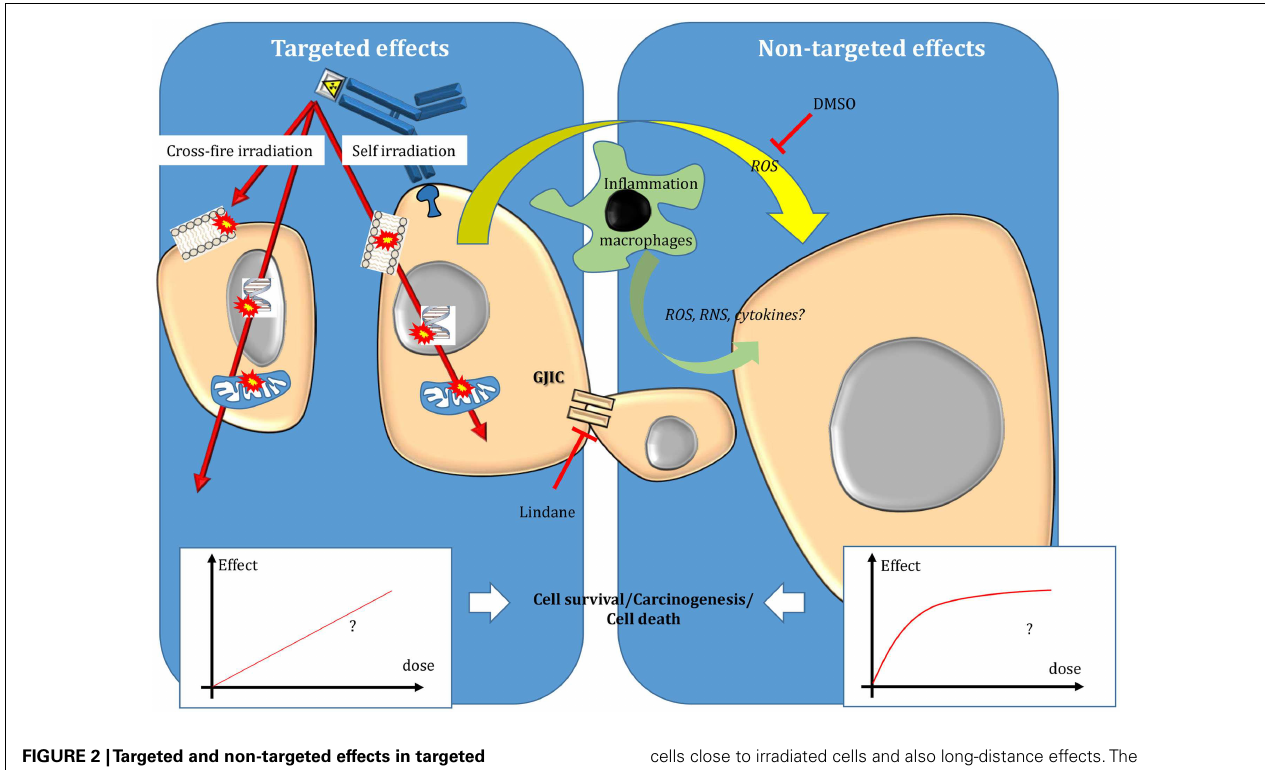
FIGURE 2 |Targeted and non-targeted effects in targeted radionuclide therapy .Targeted effects are caused by one or more particles crossing irradiated cells and can be due to self-irradiation and cross-fire irradiation. Non-targeted effects include effects observed in